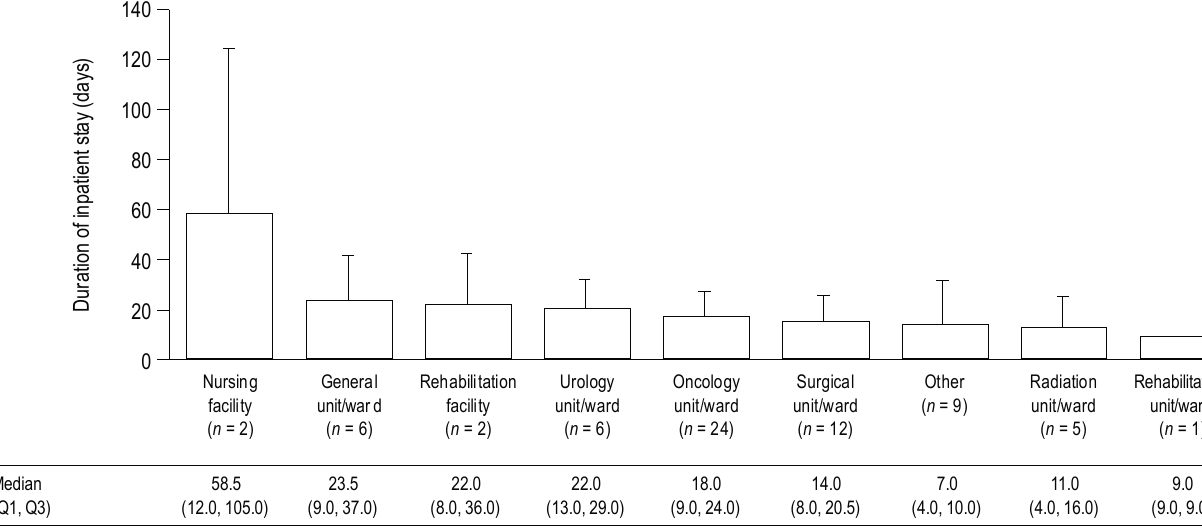
Figure 3. Mean duration of inpatient stays according to healthcare facility type, for all SREs combined. Data shown as mean (+standard deviation) duration of inpatient stays according to healthcare facility type for all SREs combined. Median (Q1, Q3) values are displayed below the graph. If an SRE was associated with multiple inpatient stays, the total duration of all related stays was